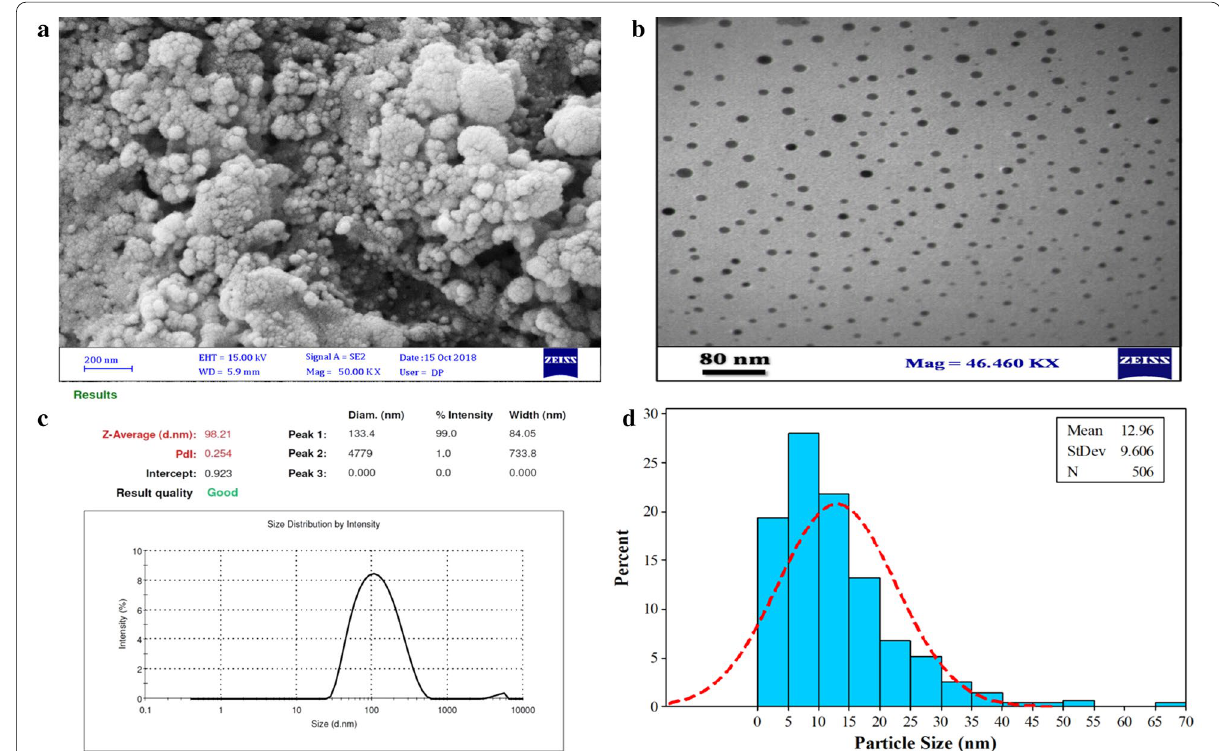
Fig. 2 a SEM analysis of green-synthesized AgNPs under optimal conditions, b TEM micrographs of synthesized AgNPs, c DLS analysis, and d histogram of particle